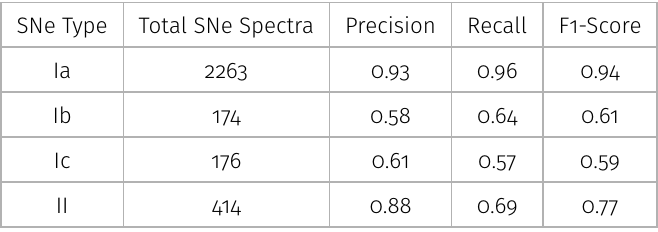
Table I. Results for the validation of the DANI model for the classification of the classic types of